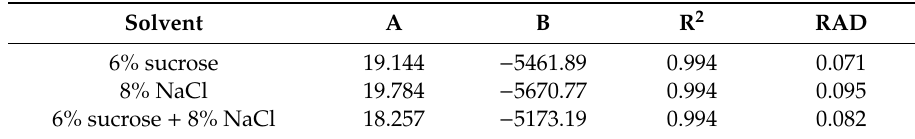
Table 4. Parameters of the simplified Apelblat equation for β -Cyclodextrin in the sucrose, NaCl, and mixed solutions.